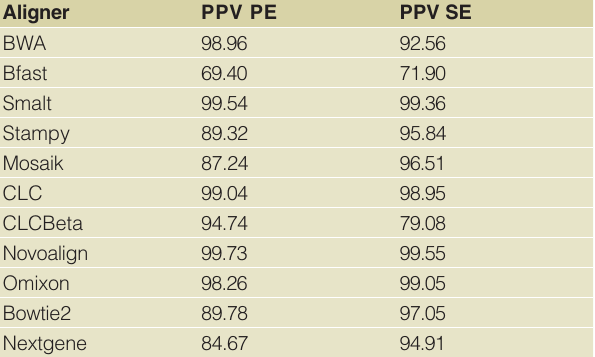
Table 6. Positive predictive values (PPVs) calculated for each aligner in single and paired-end mode based upon detection of mutations across 67 groups of simulated Illumina reads each containing 20 SNPs and 13 INDELs. In this case PPV is the total number of true positives divided by the sum of the total number of true positives and true